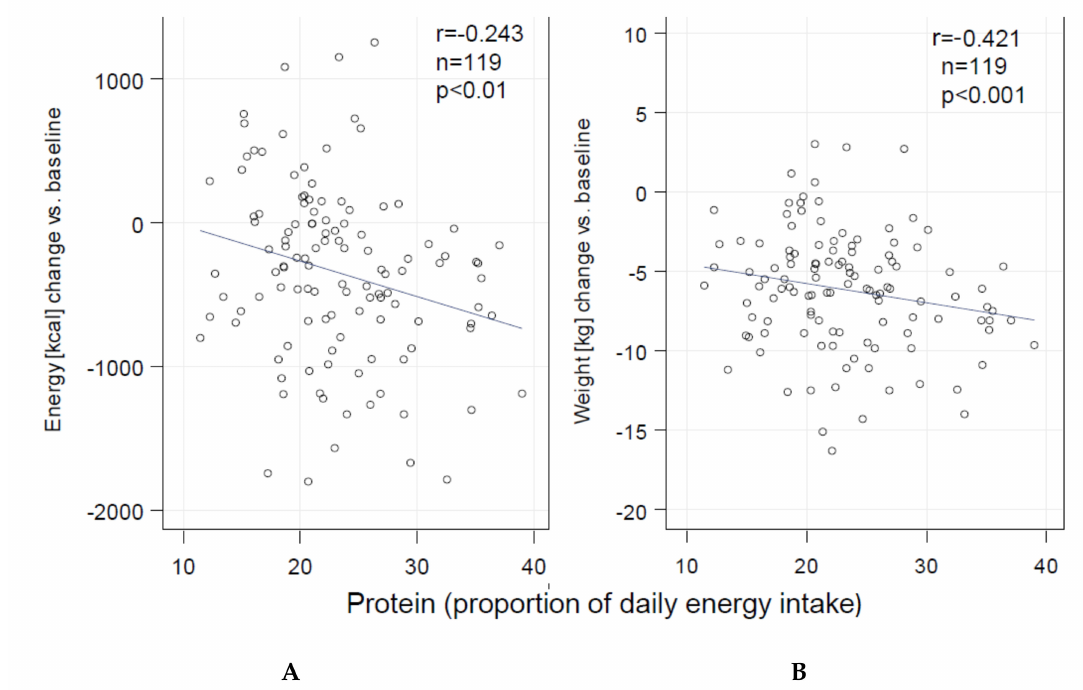
Figure 2. Association of protein intake (% of daily energy intake) of the whole cohort (INT + CON) (change from baseline to 12 weeks of intervention) with ( A ) energy and ( B ) weight